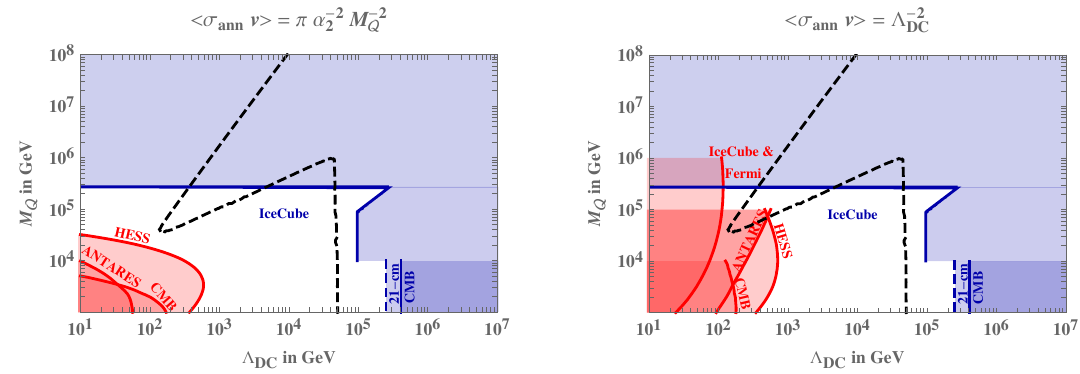
Figure 6 . Exclusion limits from experimental searches sensitive to the DM annihilation (red regions) and decay (blue regions). The limits from DM annihilation respectively in the left and right panels have been obtained by adopting the two benchmarks of eq. (5.6), while limits from DM decay were derived by setting (cid:3) UV { g UV (cid:16) (cid:22) M Pl (cid:16) 2 : 4 (cid:2) 10 18 GeV and f (cid:31) (cid:16) 3(cid:3) DC {p 4 (cid:25) q in eqs. (2.4),